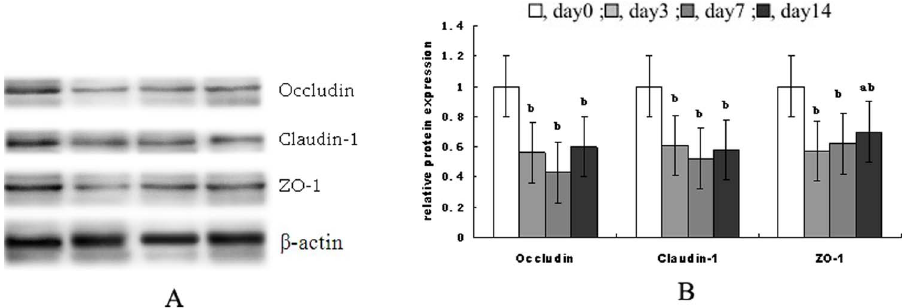
Figure 1. Tight junction protein levels of occludin, claudin-1 and zonula occludens-1 (ZO-1). (A) shows representative blots of occludin, claudin, zonula occludens-1 (ZO-1), and b -actin on 0, 3, 7 and 14 post-weaning, respectively. (B) shows relative tight junction proteins expression. Data are means 6 SD. a,b Means with different letters differ significantly ( P , 0.05). The control sample on day 0 post-weaning was used as the reference sample. The protein expression of all samples was expressed as fold changes, calculated relative to the control group on day 0 post- weaning. doi:10.1371/journal.pone.0104589.g001 PLOS ONE |